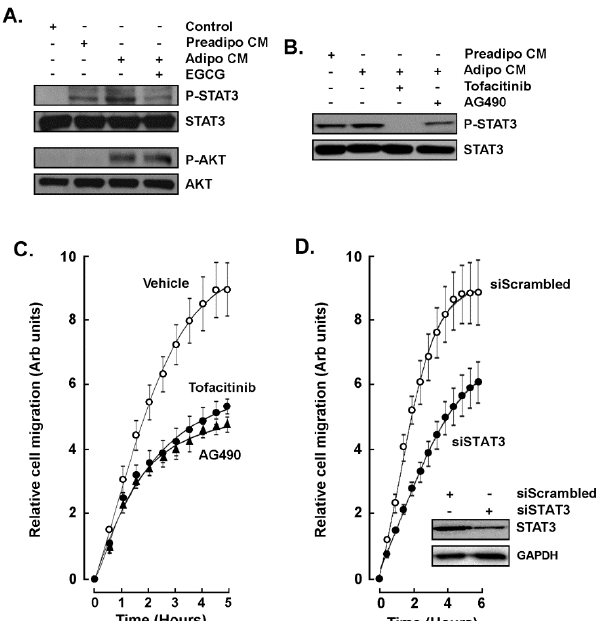
Figure 5. STAT3 involvement in the paracrine chemotaxis response to adipocytes secretome. ( A ) MDA-MB-231 cells were treated for 24 h in the presence of basal media (Control), ADMSC condi-